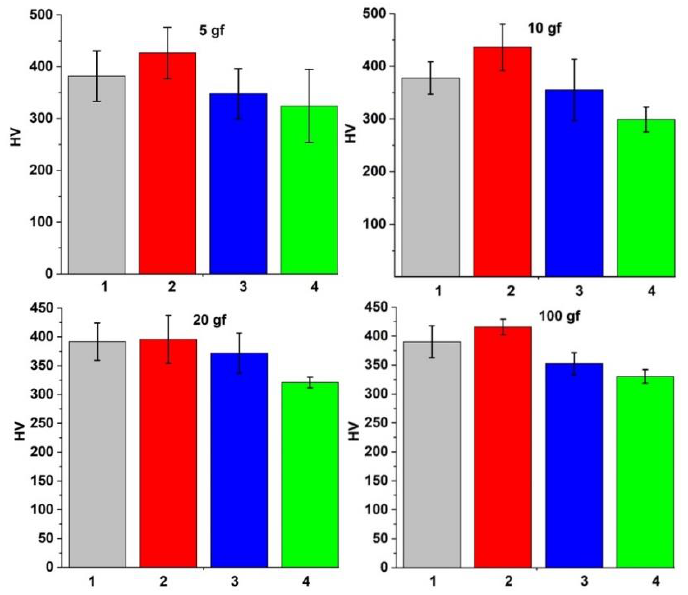
Figure 4. HV measurements of samples: (1) quenched in oil, (2) quenched in water, (3) without thermal treatment, and (4) quenched in oven.